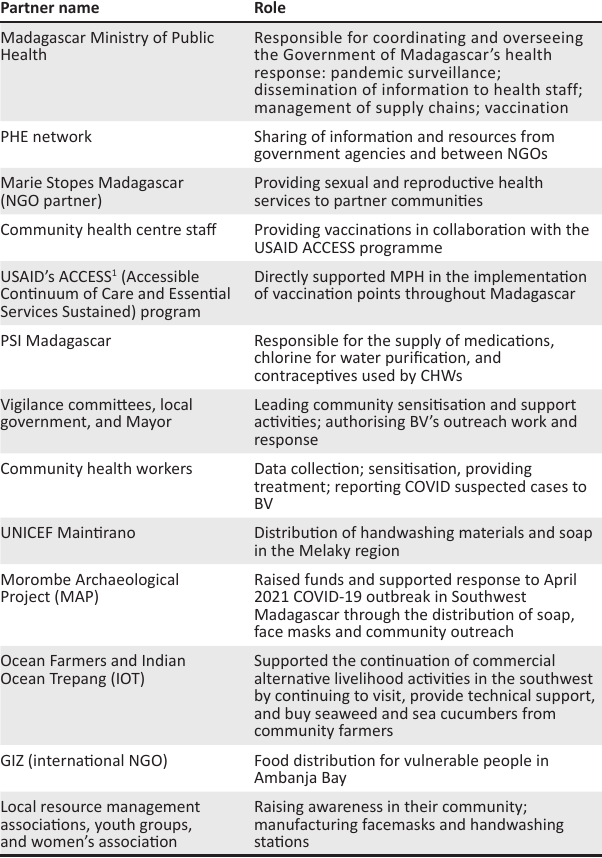
TABLE 1: Collaborators and partners for Blue Venture’s COVID-19 response in Madagascar and their roles. Partner